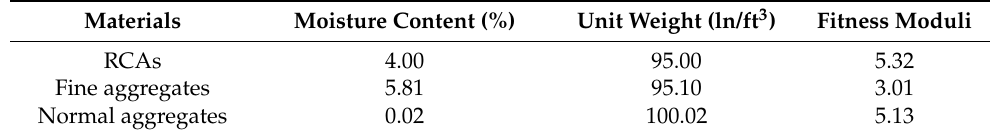
Table 2. Aggregates characteristics.